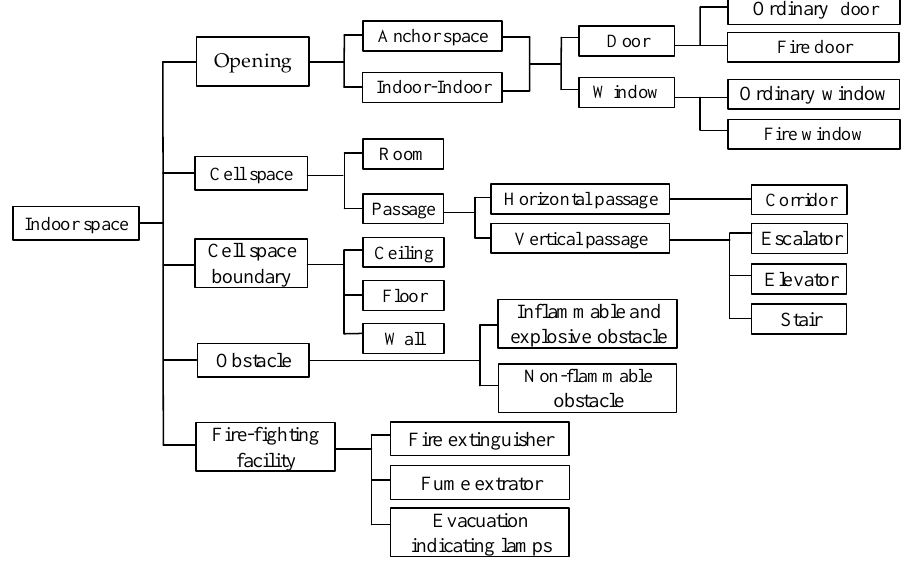
Figure 1. Indoor semantic structure for indoor fire scenarios.